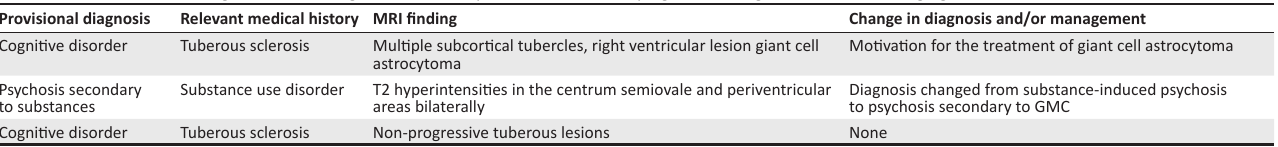
TABLE 4: Clinical features, diagnosis and management of three patients with clinically significant magnetic resonance imaging